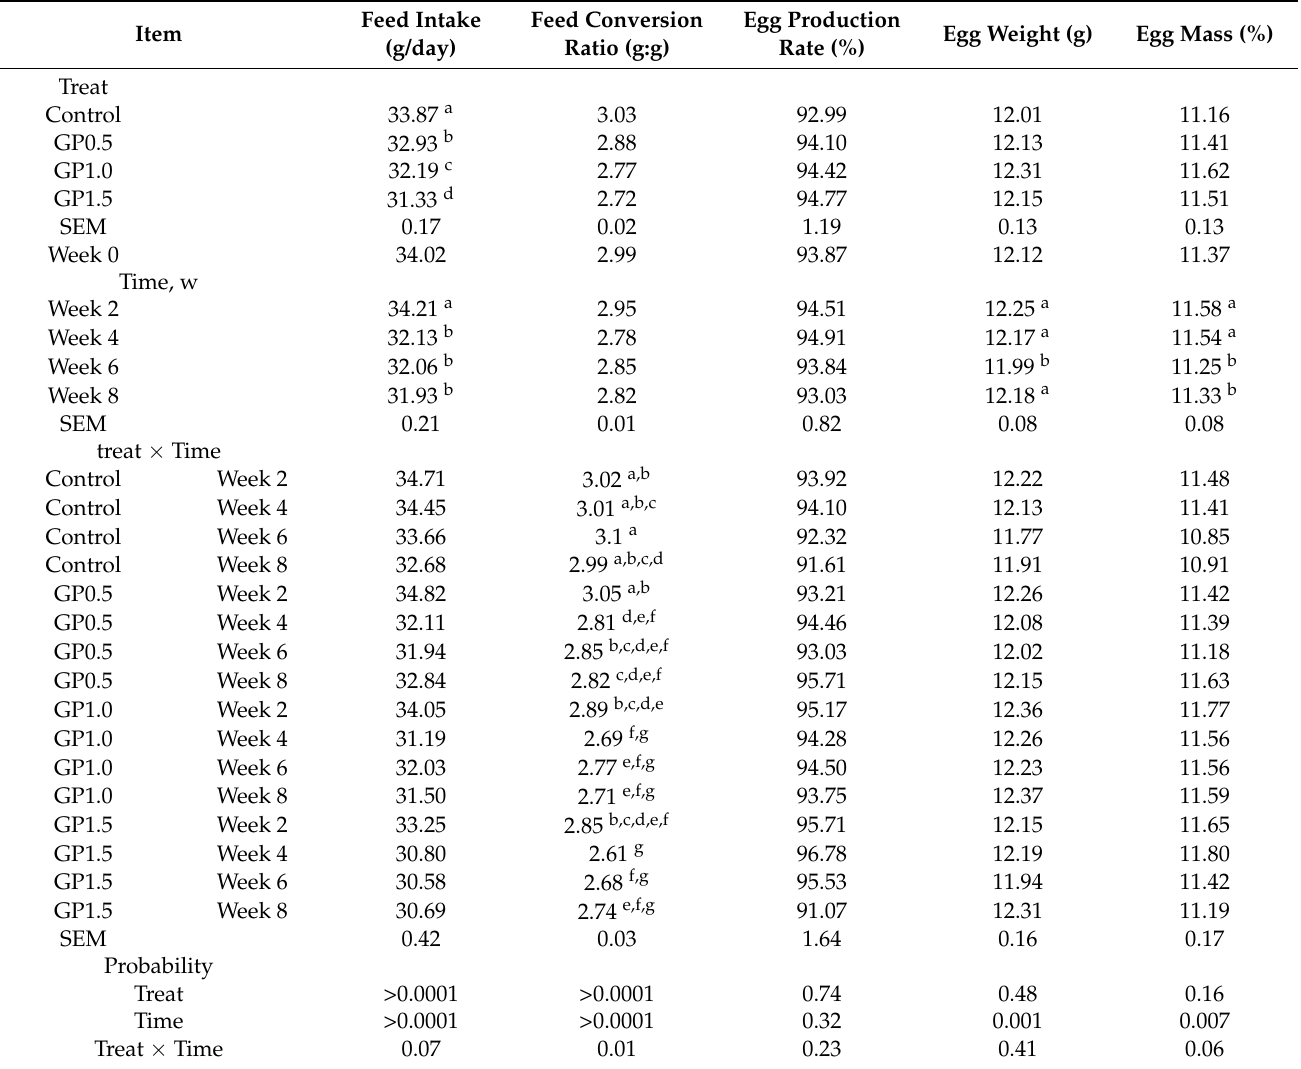
Table 3. Effects of ginger powder supplementation on productive performance in Japanese